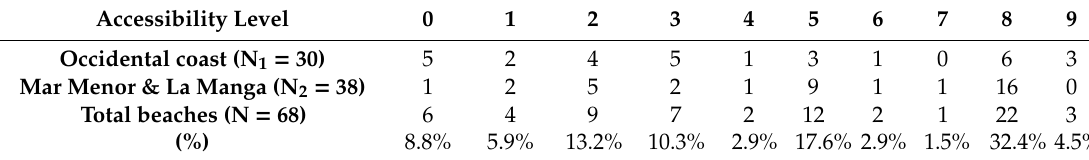
Table 3. Number of beaches in each accessibility level and in each geographical area, obtained from the field study for the 2018 update. The levels of accessibility are defined in Table 2.